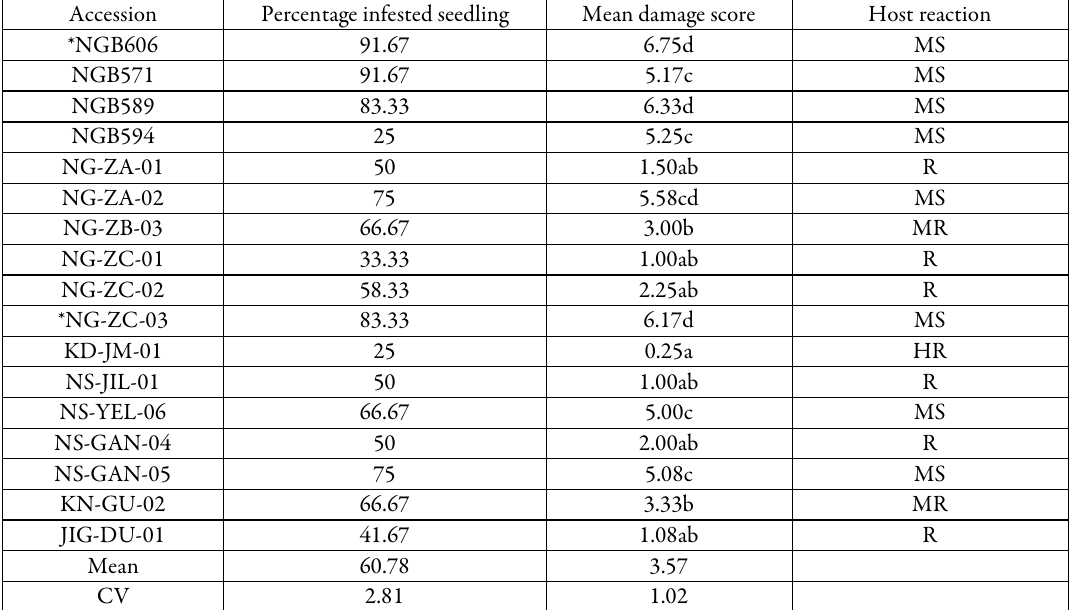
Table 4. Reaction of selected pearl millet accessions to artificial stem borer